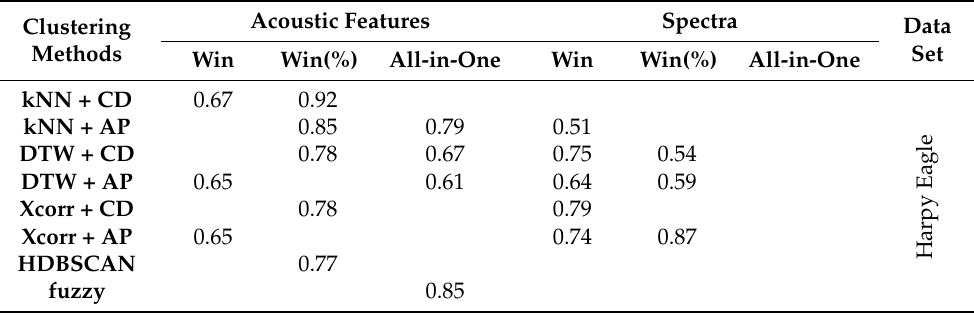
Table 3. NMI values of the comparison between the labeling of the different clustering methods and the authors’ rated label. Only the NMI values that were achieved by clustering methods that met the threshold values for both NMI and ∆ -Cluster are shown.